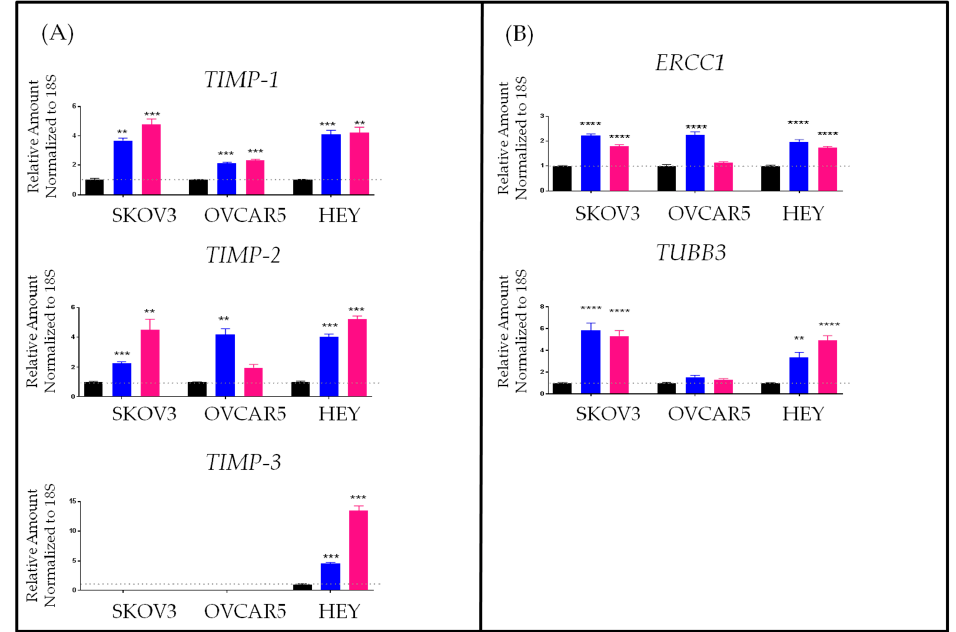
Figure 3. mRNA expression of TIMP-1, TIMP-2, TIMP-3, ERCC-1 and TUBB3A in ovarian cancer cell lines treated with or without paclitaxel or cisplatin. ( A ) TIMP-1 , TIMP-2 and TIMP-3 mRNA expression was deduced in